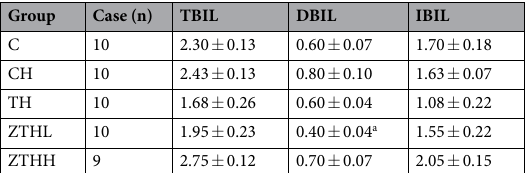
Table 2. Effect of zinc and selenium tea on the serum levels of TBIL, DBIL, and IBIL in experimental groups (mean and SEM) ( μ mol/L). a Vs CH-group, p < 0.05.